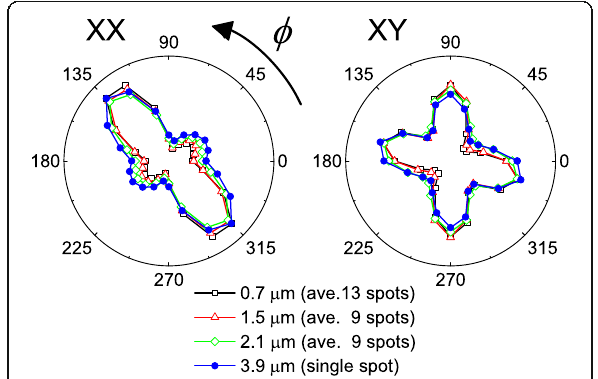
Fig. 4 Second harmonic generation (SHG) results obtained with a beam size of 3.9 μ m. Also shown are the three other curves for the different beam sizes which are obtained as averages over several points